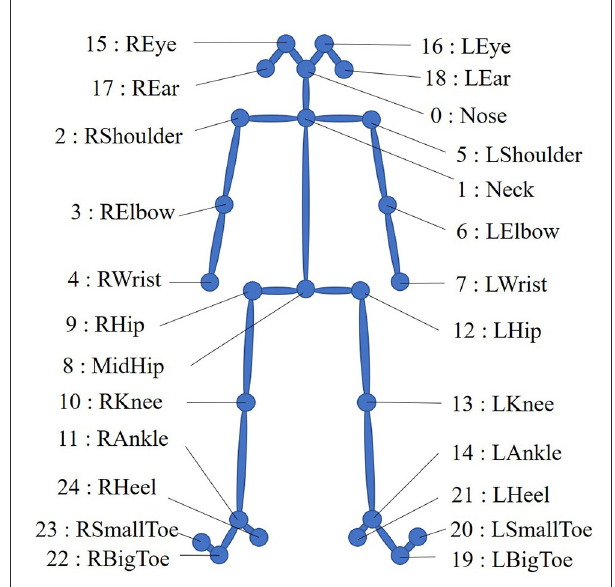
FIGURE2 Twenty-five human body key points in OpenPose.